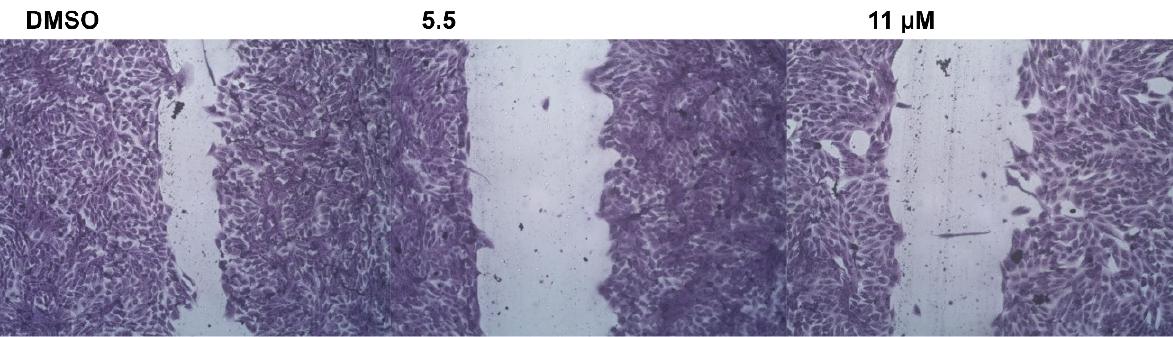
Figure 10. Inhibition of wound healing in 12b- treated HepG2